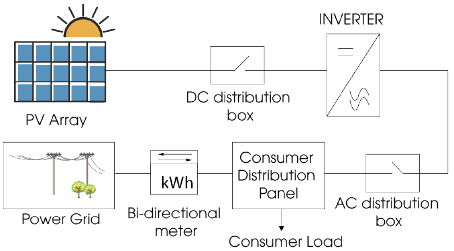
Figure 1. Diagram of the typical grid-connected PV system in